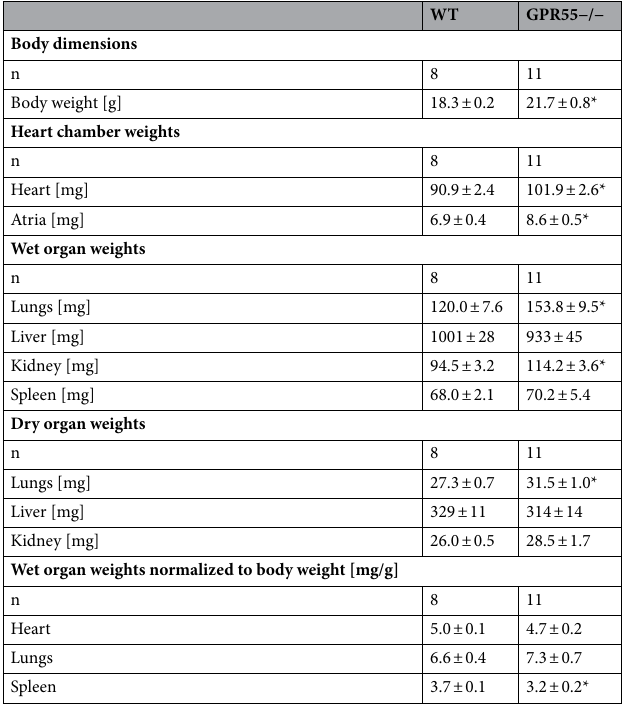
Table 1. Basal phenotype of female mice aged 8 weeks, determined via gravimetry. Mean ± SE, *p < 0.05 vs. WT, student’s